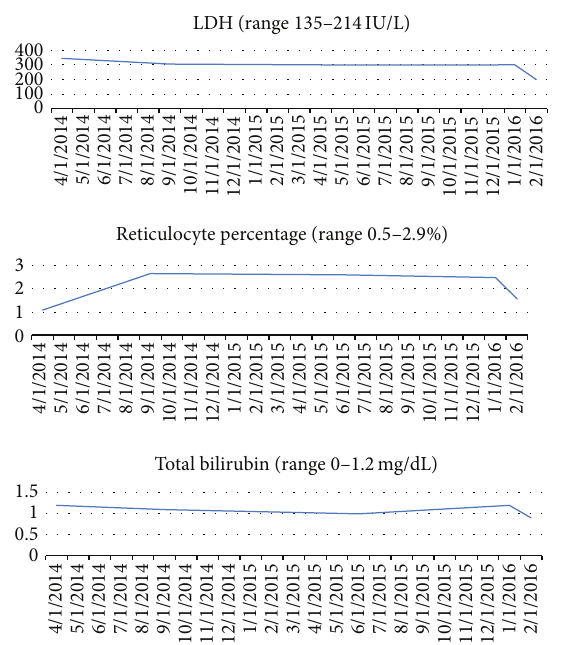
Figure 10: Graphs showing lactate dehydrogenase (LDH), reticulo- cyte percentage, and total bilirubin levels in the first